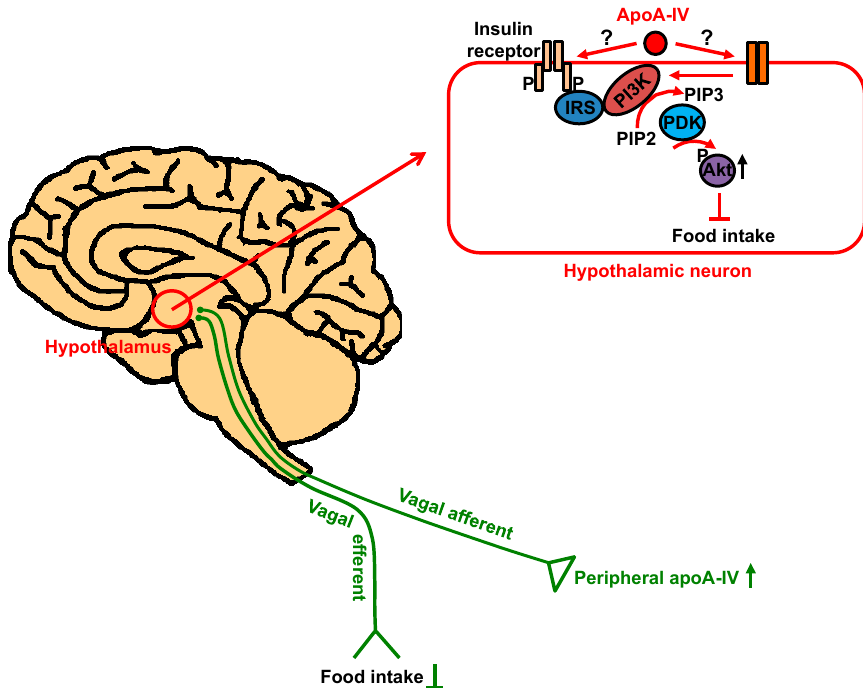
Figure 3. The regulation of food intake by apoA-IV. ApoA-IV expressed in the central nervous system suppresses food intake via PI3K/Akt pathway in the hypothalamic neurons. The signal elicited by peripheral apoA-IV is relayed to the brain by vagal nerve to inhibit food intake.